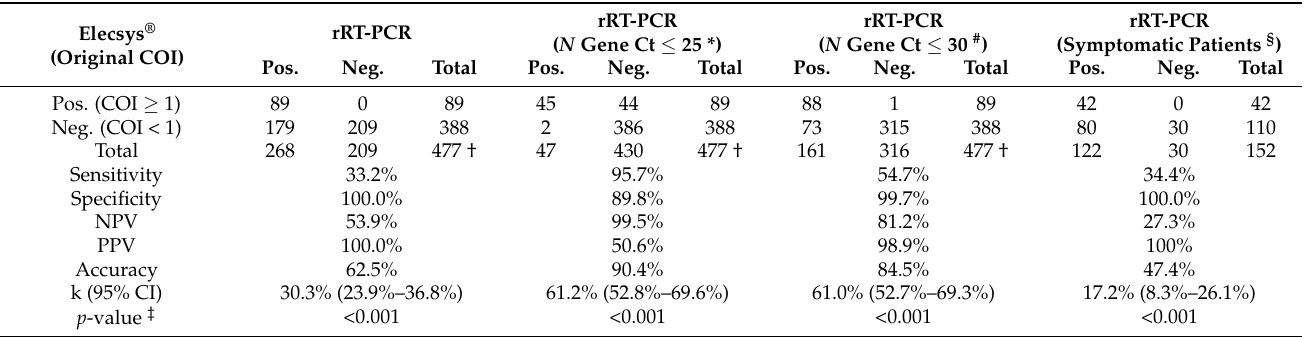
Table 5. Results of reference method (rRT-PCR) and tested method (Elecsys ® SARS-CoV-2 Antigen assay) using the manufacturer’s specified cut-off